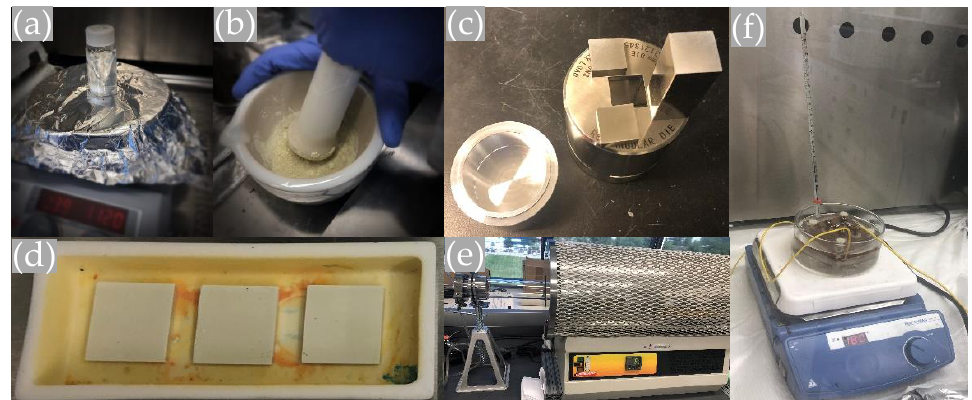
Figure 4. The fabrication procedure for the piezosensors: ( a ) dissolving polyvinyl alcohol (PVA) in deionized (DI) water; ( b ) mixing and grinding PZT powder with the PVA solution; ( c ) the mold used to press the powder; (d) pressed samples placed in the alumina boat; ( e ) furnace tube used to sinter the powder; and ( f ) the poling process under controlled voltage and temperature.